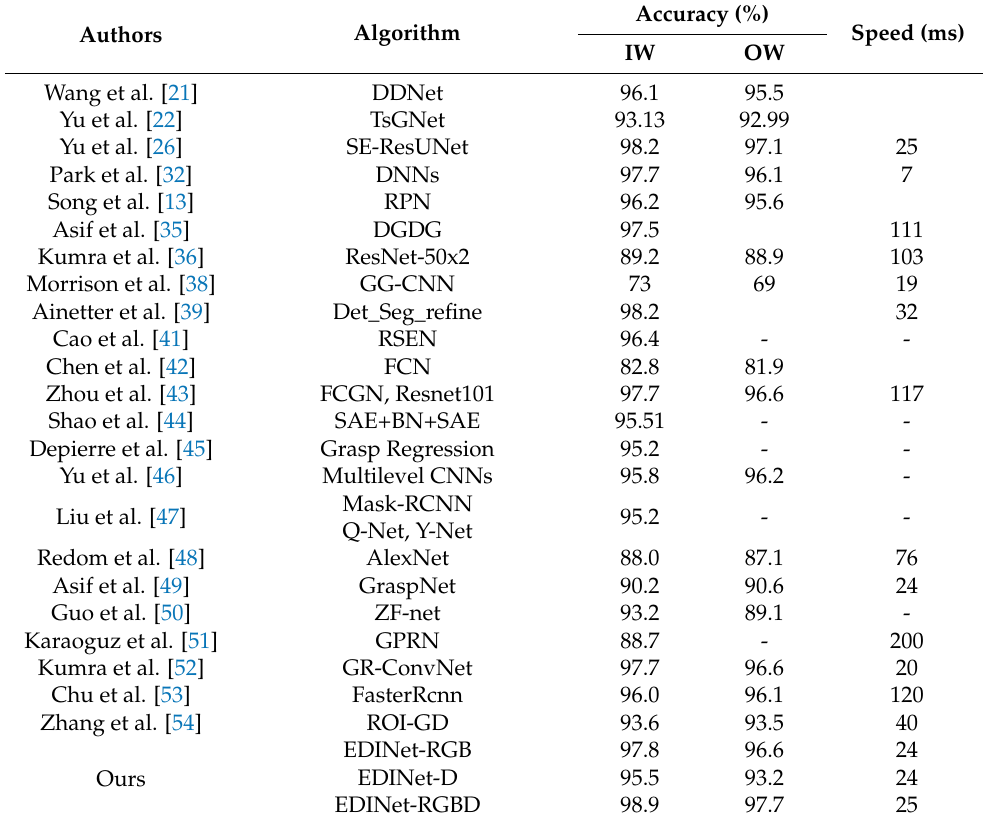
Table 2. Evaluation results on Cornell grasp dataset.